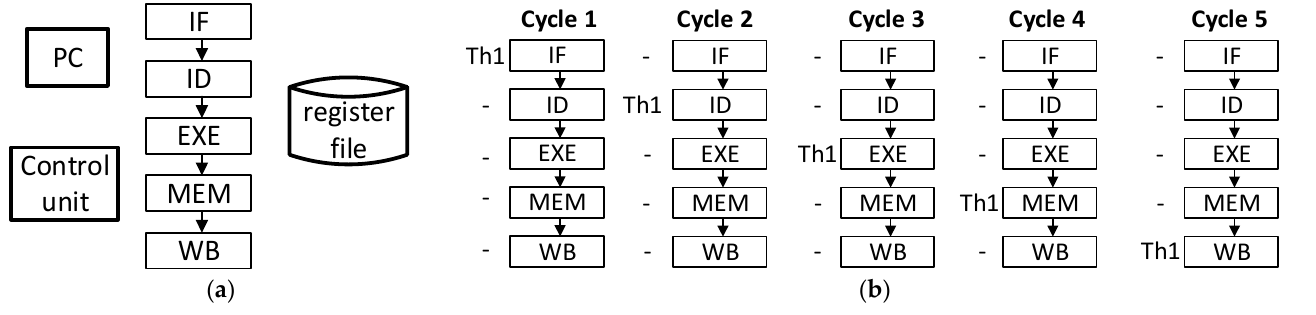
Figure 3. Structure of a classical simple processor ( a ) and subsequent instruction’s cycles ( b ).